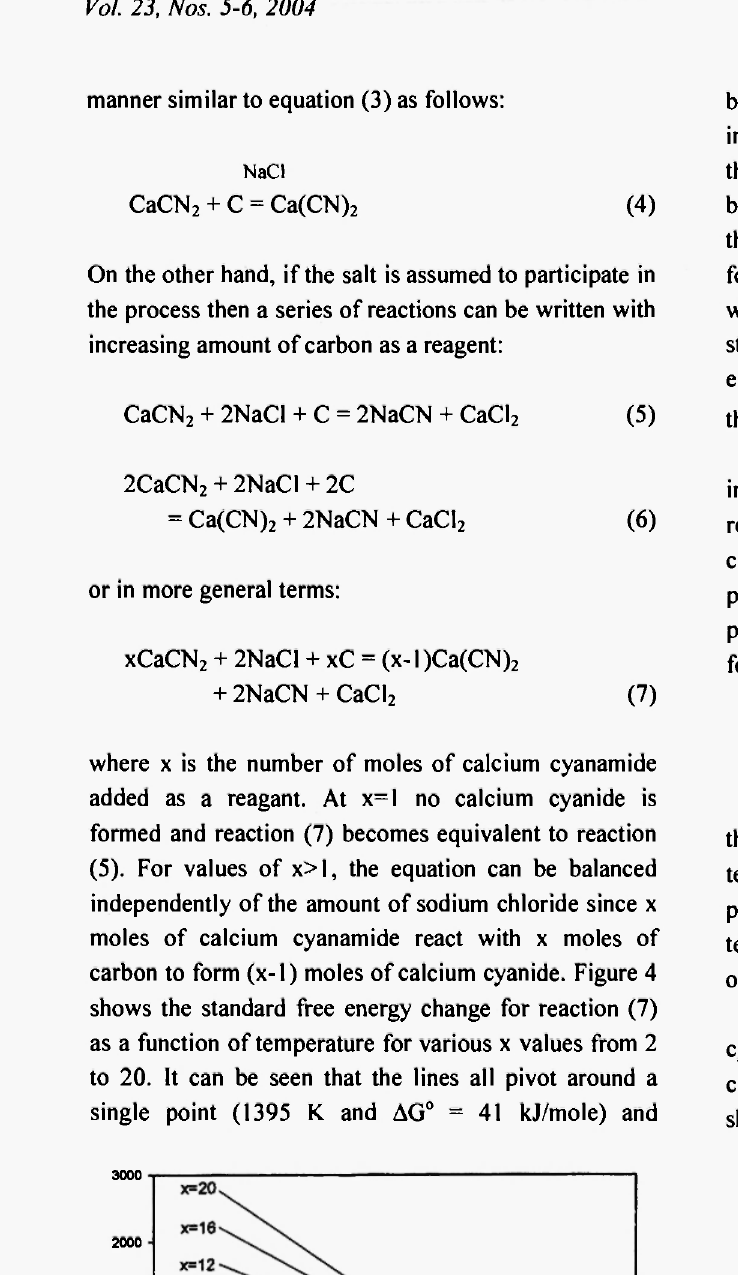
Fig. 4: Standard free energy changes for the reaction of calcium cyanamide, sodium chloride and carbon at various χ values.